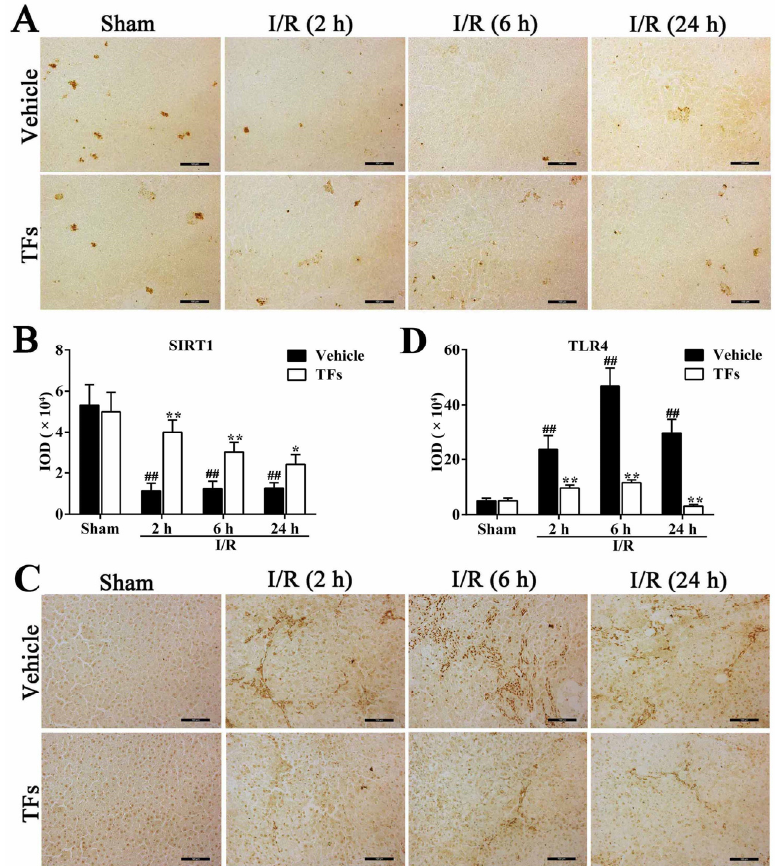
Figure 4. TFs downregulated Sirt1 and upregulated TLR4 protein levels after I/R injury. ( A ) Effects of TFs on Sitr1 protein level (brown areas) in liver tissue after 1 h of ischemia and different times of reperfusion (2 h, 6 h, and 24 h); ( B ) statistical analysis of the IOD values of Sitr1 protein level; ( C ) effects of TFs on TLR4 protein level (brown areas) in liver tissue after 1 h of ischemia and different times of reperfusion (2 h, 6 h, and 24 h); and ( D ) statistical analysis of the IOD values of TLR4 protein levels. Data are presented as the mean ± SD ( n = 6). # p < 0.05 and ## p < 0.01 versus sham; * p < 0.05 and ** p < 0.01 versus vehicle.